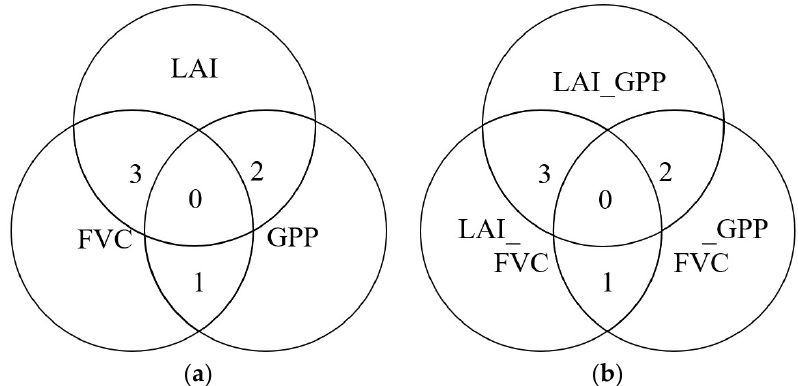
Figure 4. Comparison framework of ( a ) tendency and ( b ) correlation among three products.